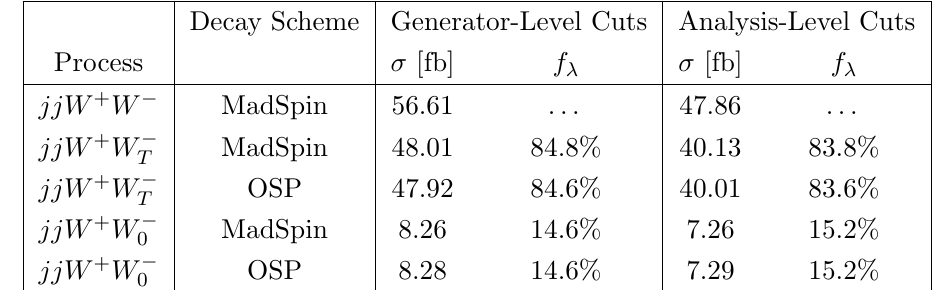
Table 4. Same as table 3 but for the mixed EW-QCD process pp ! jjW + W (cid:0)